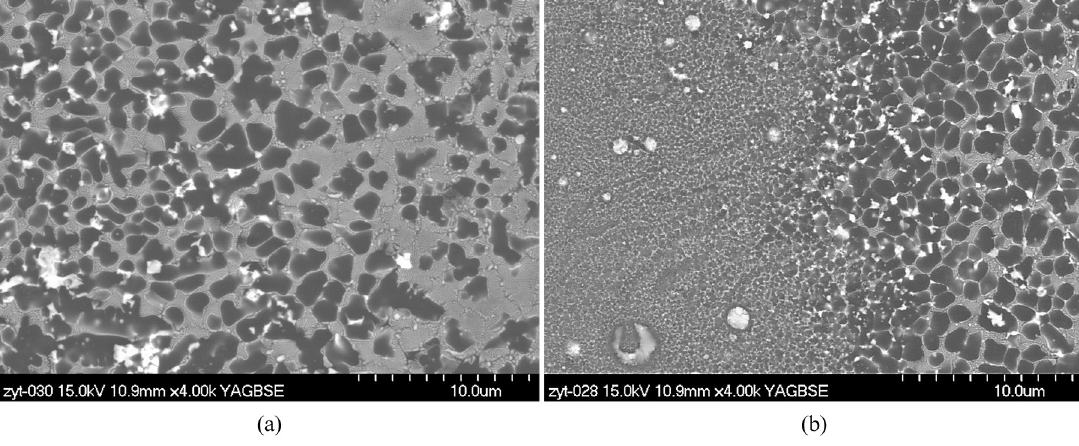
O /ZrO coating. 2 3 2